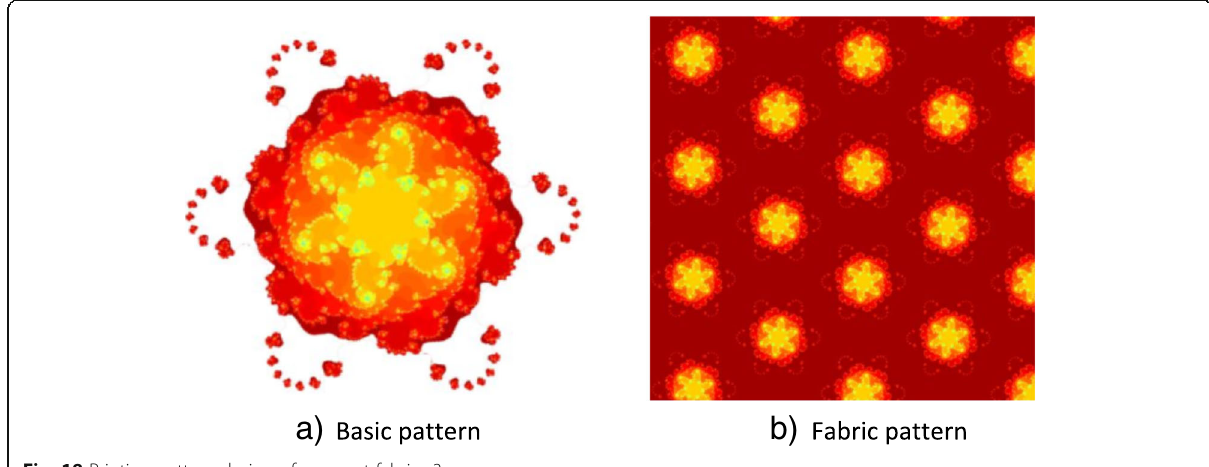
Fig. 18 Printing pattern design of garment fabrics